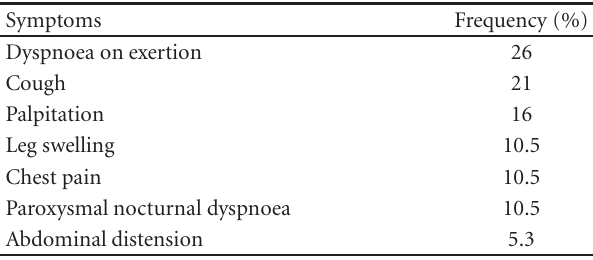
Table 1: Common symptoms at presentation.